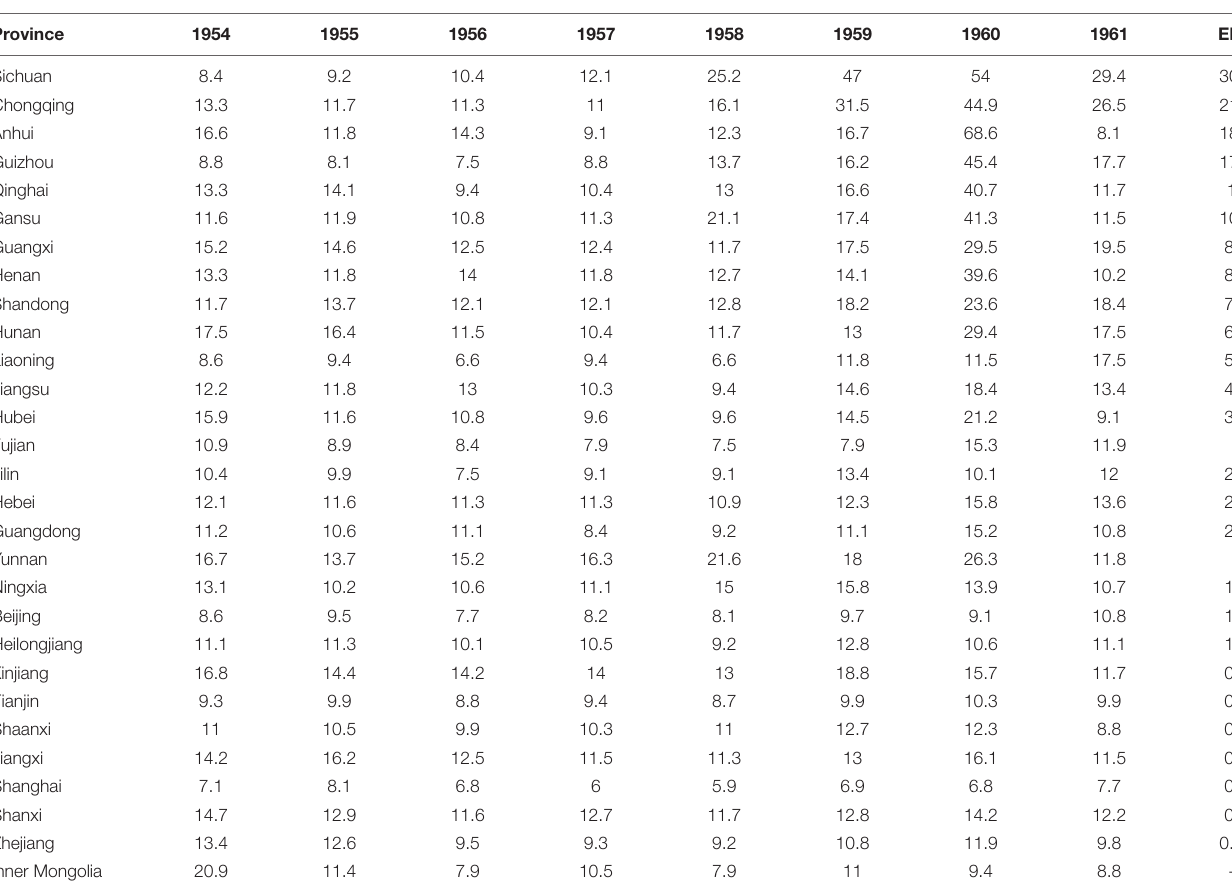
TABLE 2 | Death rates and famine severity across provinces (unit: 0.1%).